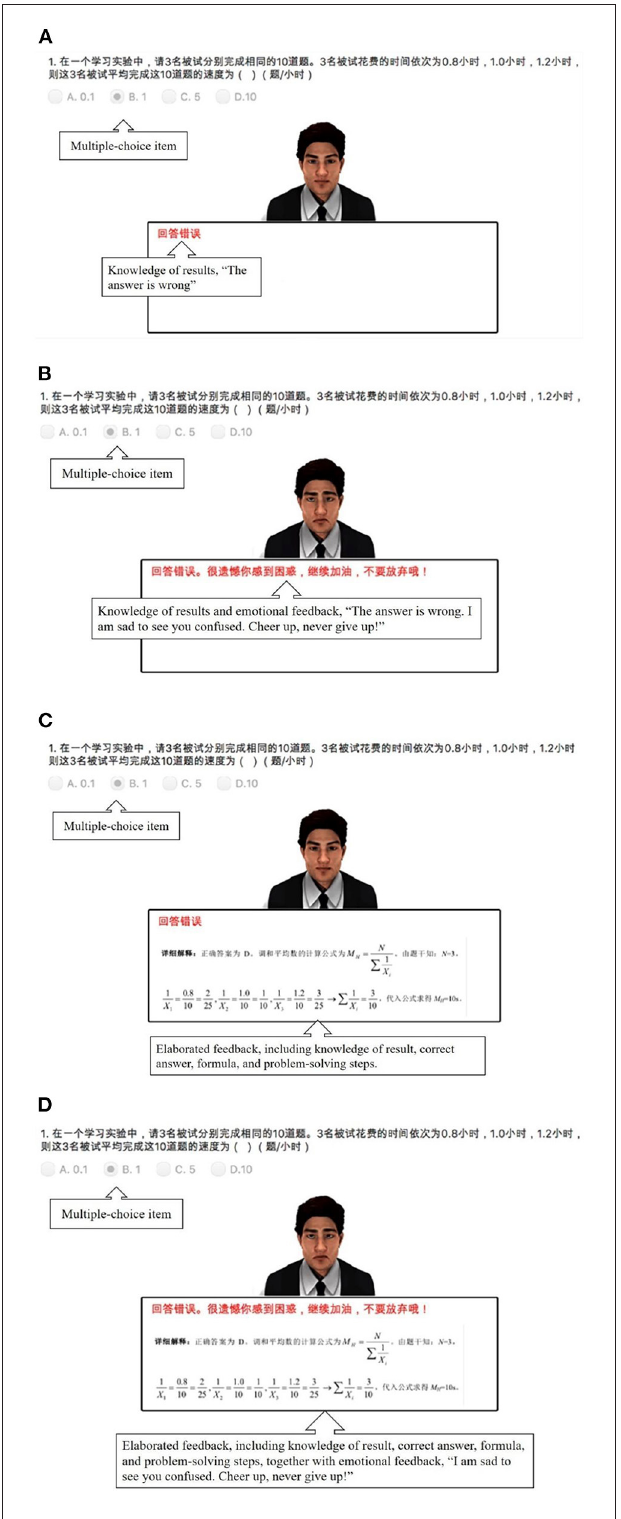
FIGURE 2 | Examples for feedback presentation in the four conditions: (A) without emotional feedback + with knowledge of results; (B) with emotional feedback + with knowledge of results; (C) without emotional feedback + with elaborated feedback; (D) with emotional feedback + with elaborated